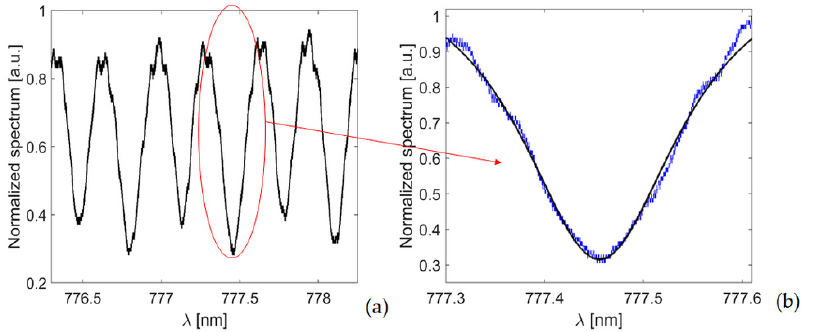
Figure 12. ( a ) Normalized transmission spectrum of the ORR. ( b ) Optical resonance at λ = 777.46 nm and Lorentzian curve fitting (black line).